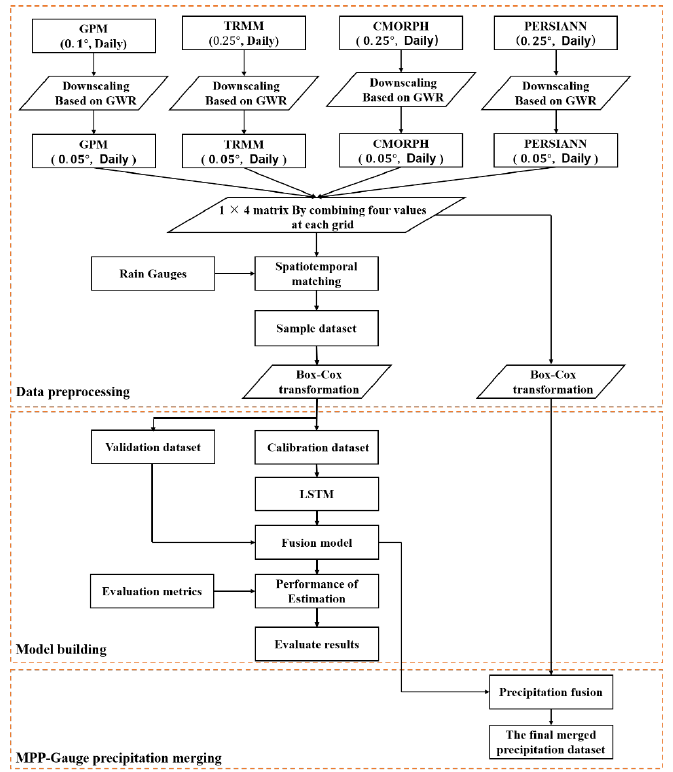
Figure 2. Flowchart of merging multisatellite and gauge precipitation based on the GWR-LSTM framework .